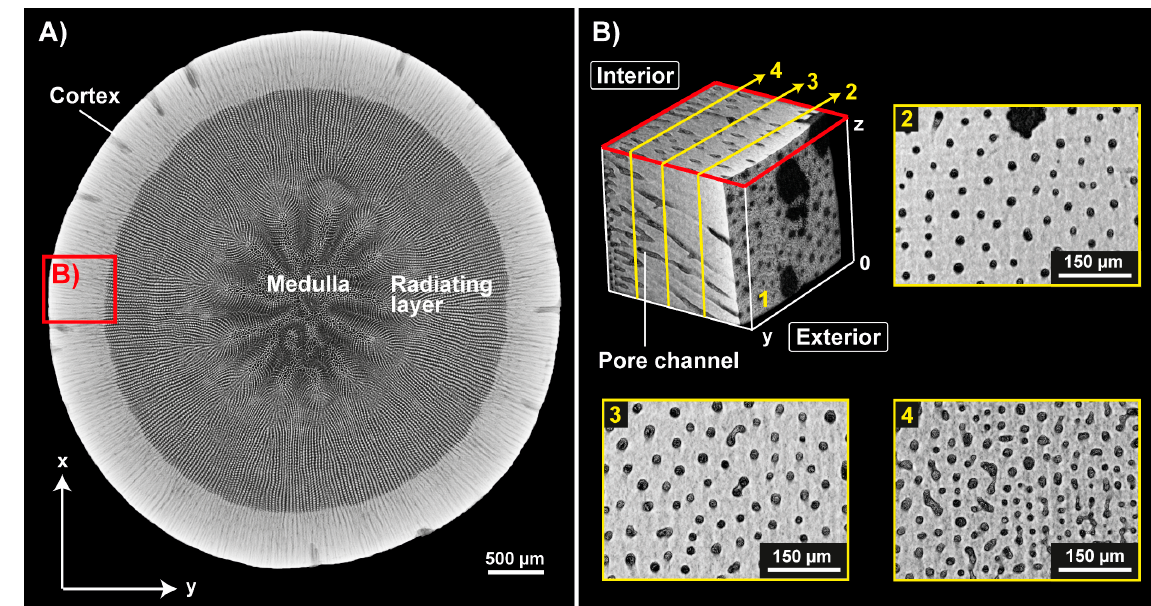
Figure 5. Microstructure of the spine of Phyllacanthus imperialis . ( A ) Z-projection of the microstructure of the spine shows the three structural units: the cortex, radiating layer and medulla. Various sections (yellow boxes) of the cortex microstructure are displayed in ( B ).